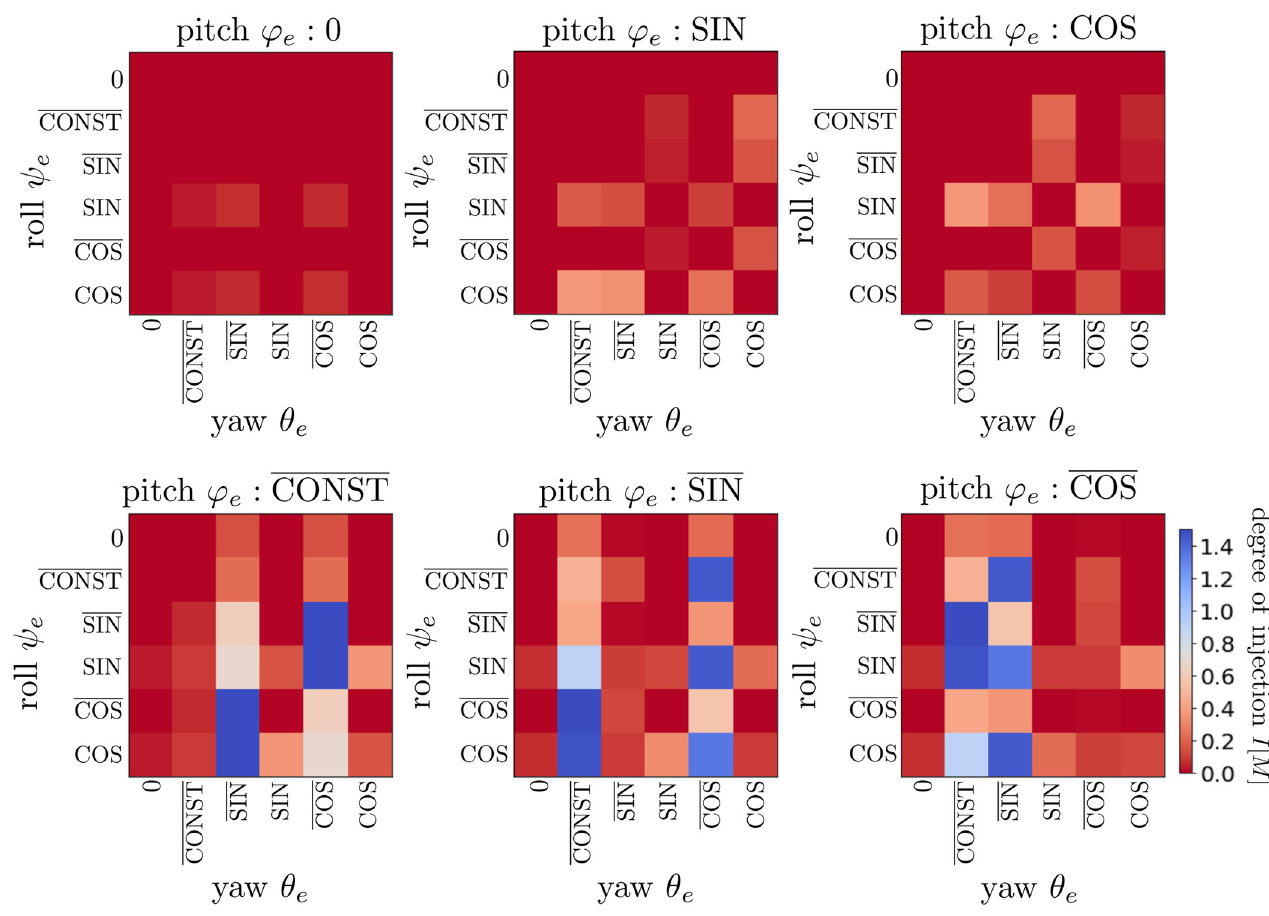
Fig 10. Colormaps of degree of injection I [ M ] of all combinations of ψ removed, so that the degrees of injection were evaluated for 6 3 = 216 motion patterns.